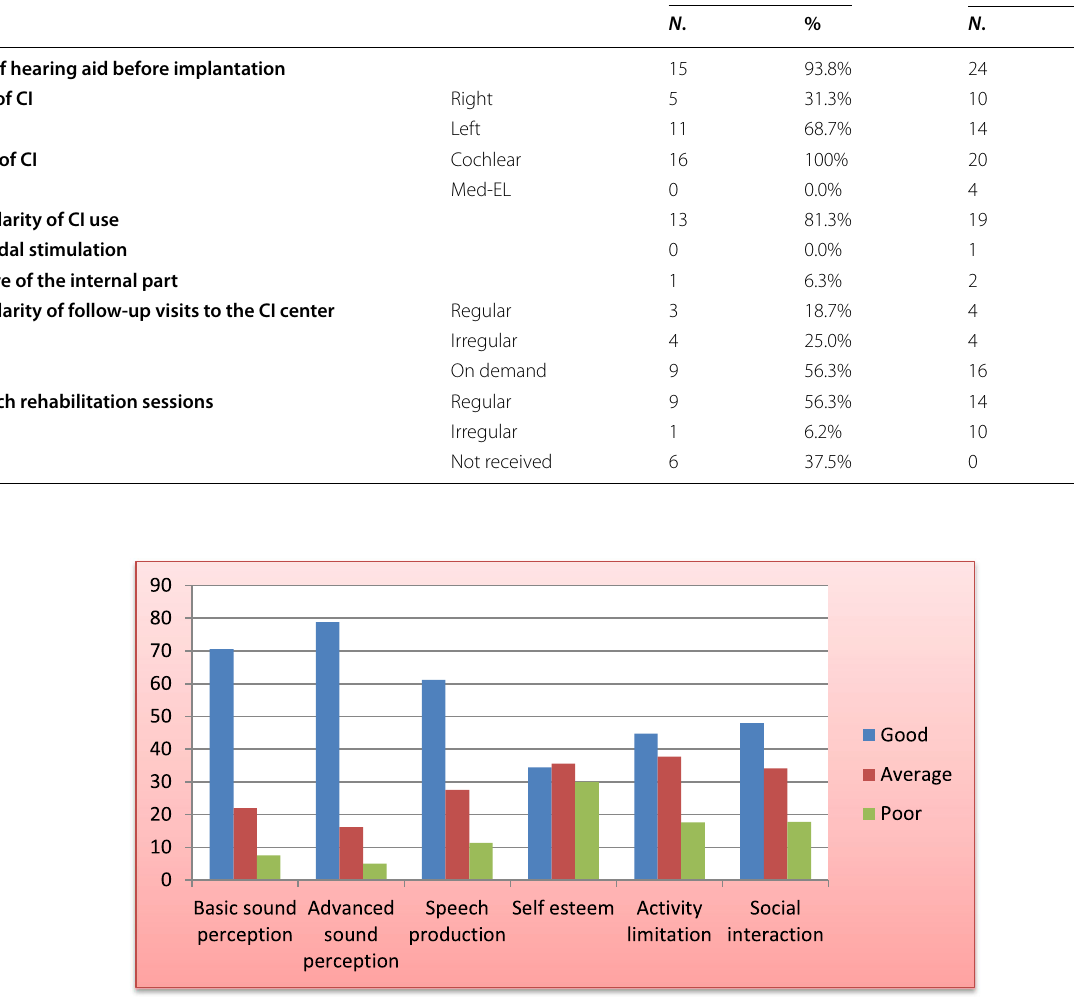
Fig. 2 Distribution of adults according to their performance in the NCIQ-Arabic version